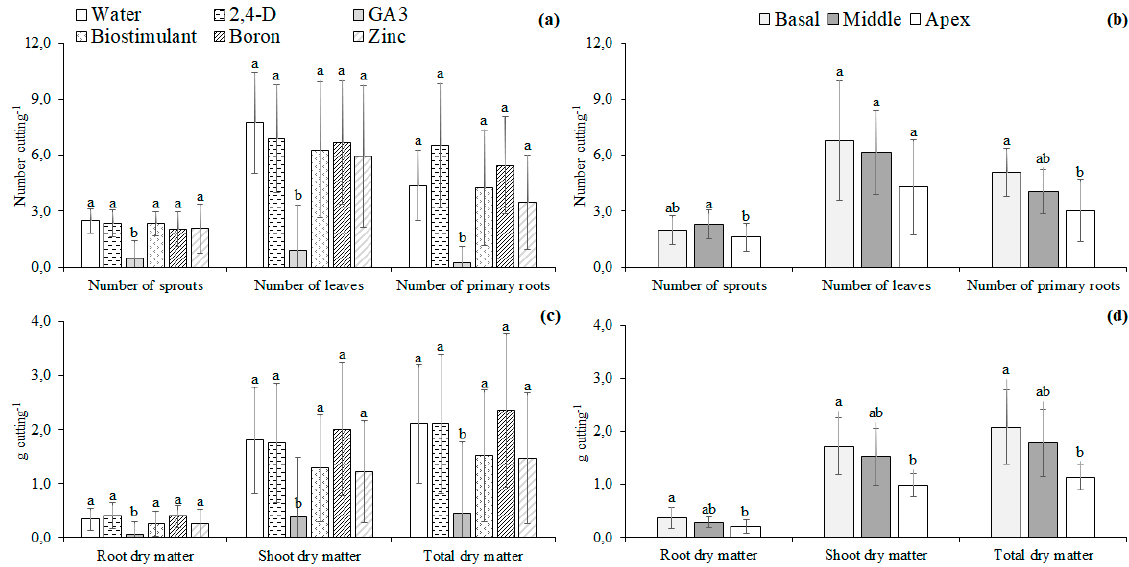
Figure 6. Number of sprouts, leaves, and roots ( a , b ); roots, shoots, and total dry matter ( c , d ) of Jatropha curcas L. saplings produced from hardwood cuttings immersed in distilled water or solutions of micronutrients or plant regulators and extracted from different parts of the branch at 120 days after planting. Different letters above each bar indicate significant differences among the immersion in water or solutions of micronutrients or plant regulators and among the parts of the branch where the hardwood cuttings were extracted by the Least Significant Difference (LSD) test at the 5% probability level. Values are represented by the mean of four independent replicates.